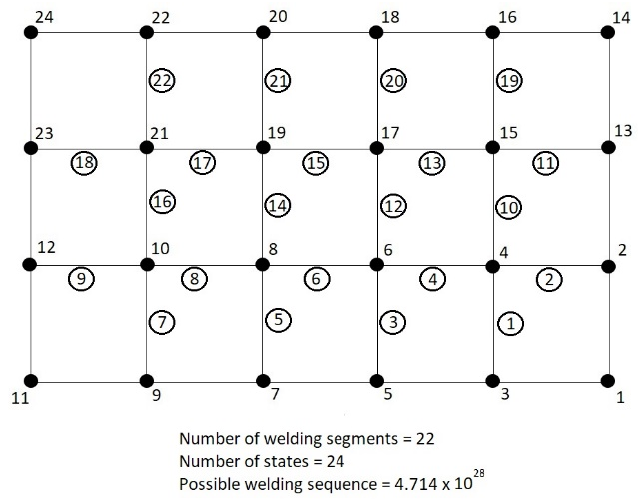
Figure 20. State action diagram for vent panel.